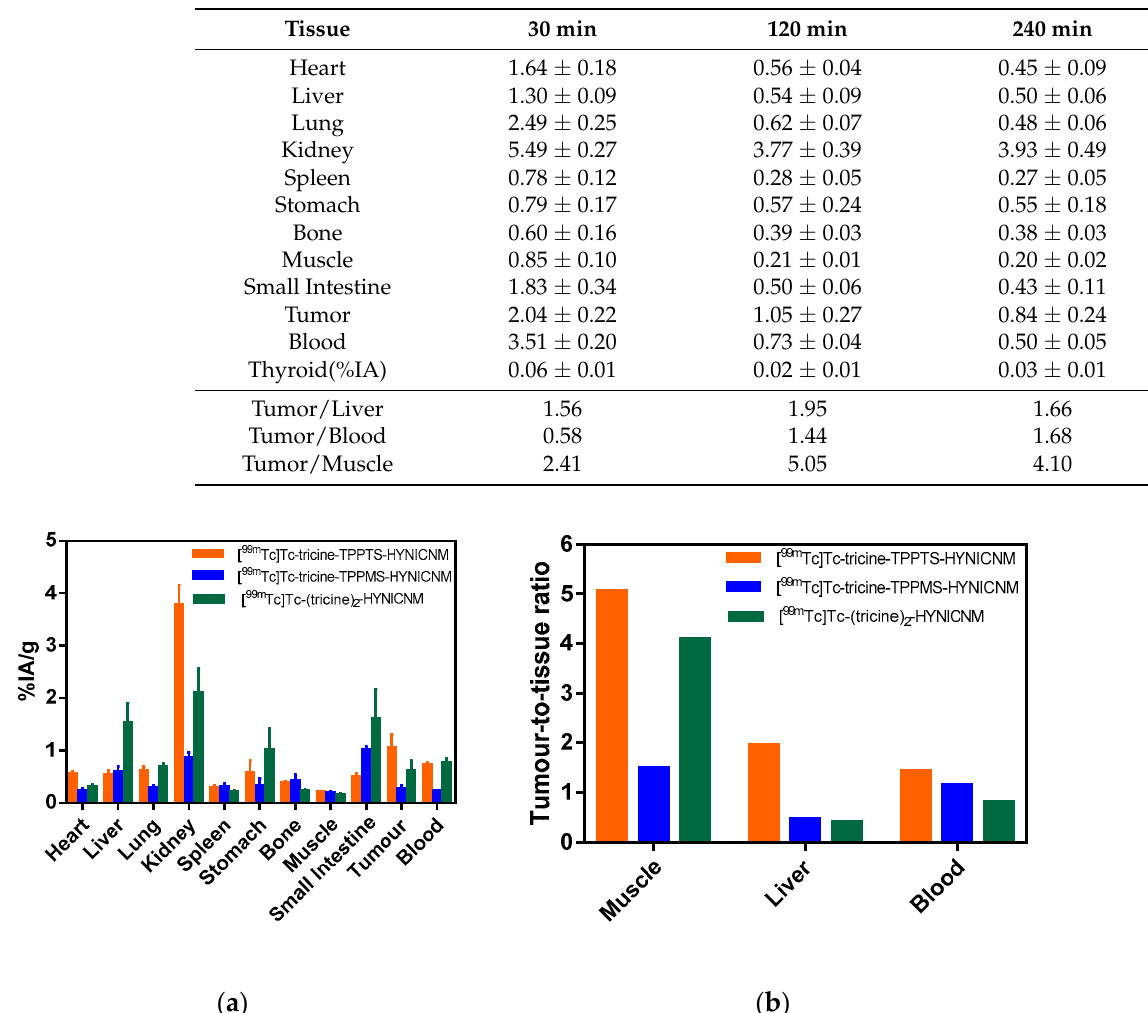
Figure 3. ( a ) Comparisons of biodistribution of [ 99m Tc]Tc-tricine-TPPTS-HYNICNM, [ 99m Tc]Tc-tricine-TPPMS-HYNICNM, and [ 99m Tc]Tc-(tricine) 2 -HYNICNM at 2 h post-injection ( n = 5). ( b ) Comparisons of the tumor-to-blood, tumor-to-muscle, and tumor-to-liver ratios of [ 99m Tc]Tc-tricine-TPPTS-HYNICNM, [ 99m Tc]Tc-tricine-TPPMS-HYNICNM, and [ 99m Tc]Tc-(tricine) 2 -HYNICNM at 2 h post-injection ( n = 5).